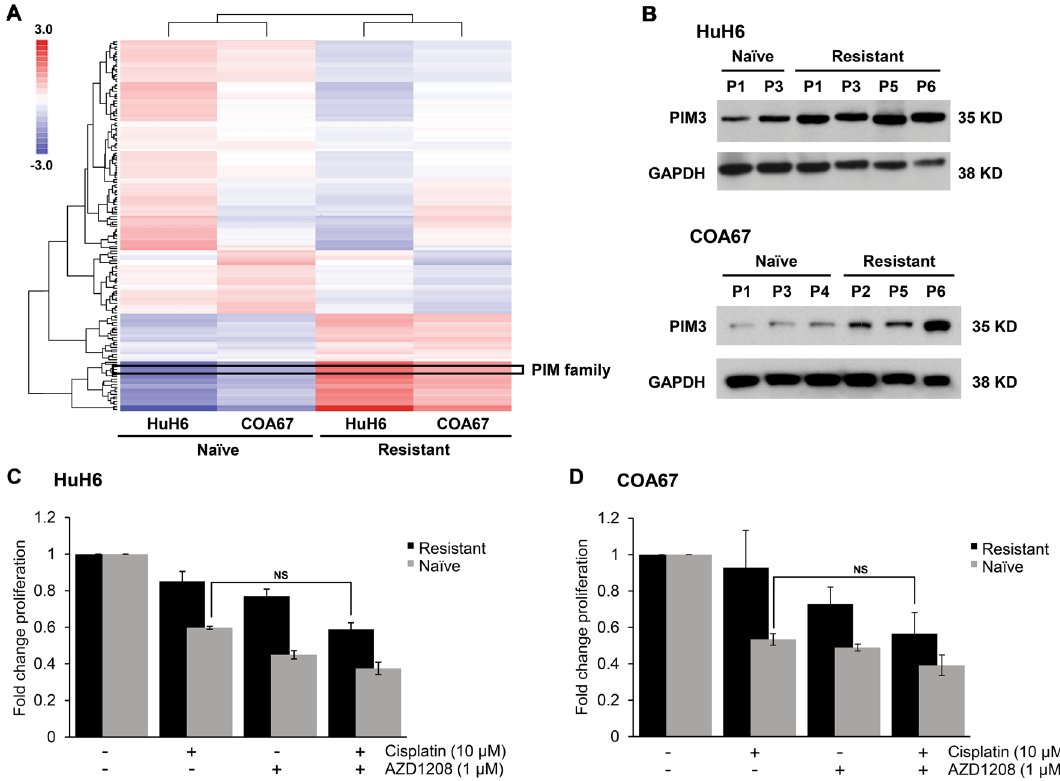
Figure 3. Cisplatin-resistant hepatoblastoma cells have higher activity and expression of PIM3 kinase and PIM inhibition increases their sensitivity to cisplatin. ( A ) Kinomic profiling of HuH6 and COA67 cisplatin-naïve and resistant cells was performed using a PamStation12 microarray. The heatmap displays kinomic signature data with kinomic peptides across all conditions (colored by log difference from mean per cell type, per peptide). Clustering is unsupervised, via a geometric means-distance method, with peptides clustered by row, and samples clustered by column. PIM family kinase targets ( boxed region shown ) were significantly activated in cisplatin- resistant compared to cisplatin-naïve HuH6 and COA67 tumors. ( B ) Immunoblotting was performed on lysates from both HuH6 and COA67 cisplatin-naïve and cisplatin-resistant tumors from various passages (P). PIM3 expression was higher in cisplatin-resistant compared to cisplatin-naïve tumors and increased as cells became more insensitive to cisplatin. GAPDH was used to confirm equal protein loading. ( C ) HuH6 and ( D ) COA67 cisplatin-naïve and resistant cells were treated with 1 µM of AZD1208, 10 µM of cisplatin, or both drugs for 72 h and proliferation evaluated with CellTiter 96 assay. The addition of AZD1208 to cisplatin reduced proliferation of resistant cells to levels comparable to those of naïve cells treated with cisplatin alone, indicating the ability of AZD1208 to sensitize resistant cells to cisplatin. NS not